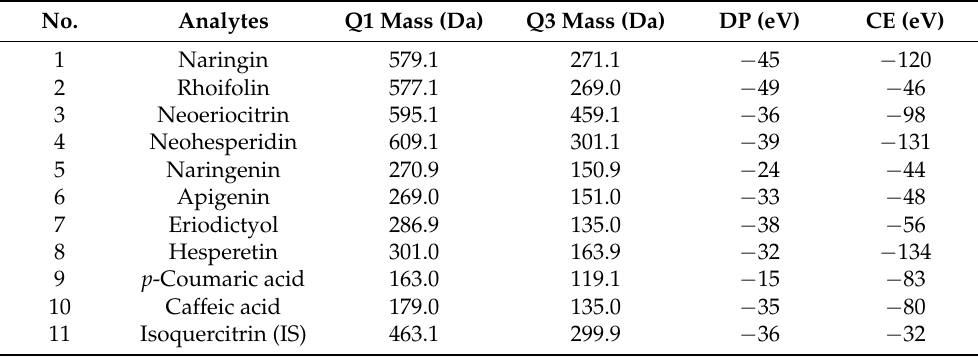
Table 1. The optimized MS/MS transitions, declustering potential (DP), and collision energy (CE) parameters for target